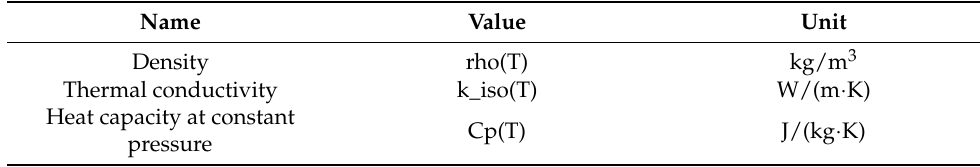
Table 3. Temperature dependent properties with